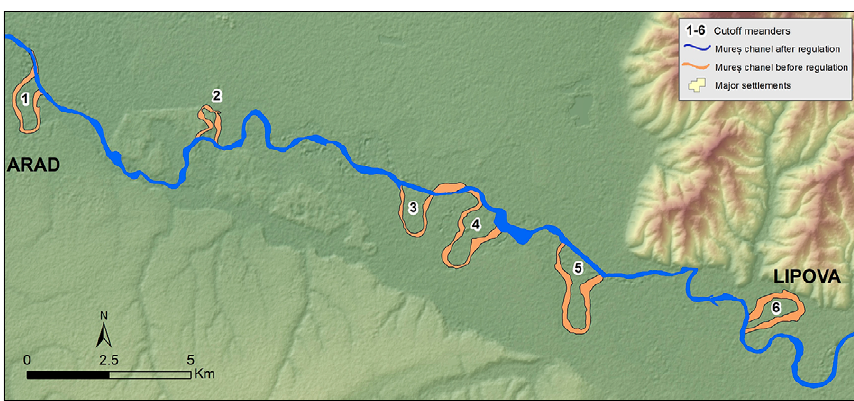
Figure 2. Meanders incised before the second part of the 19 th century